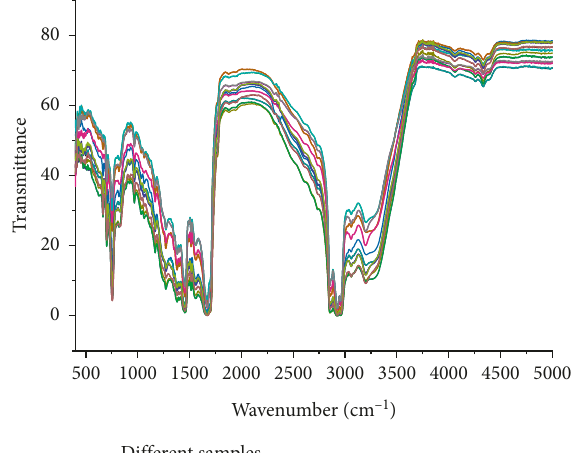
Figure 6: FT-IR spectra of bio-oil from hydrothermal liquefaction of Spirulina sp. powder under different